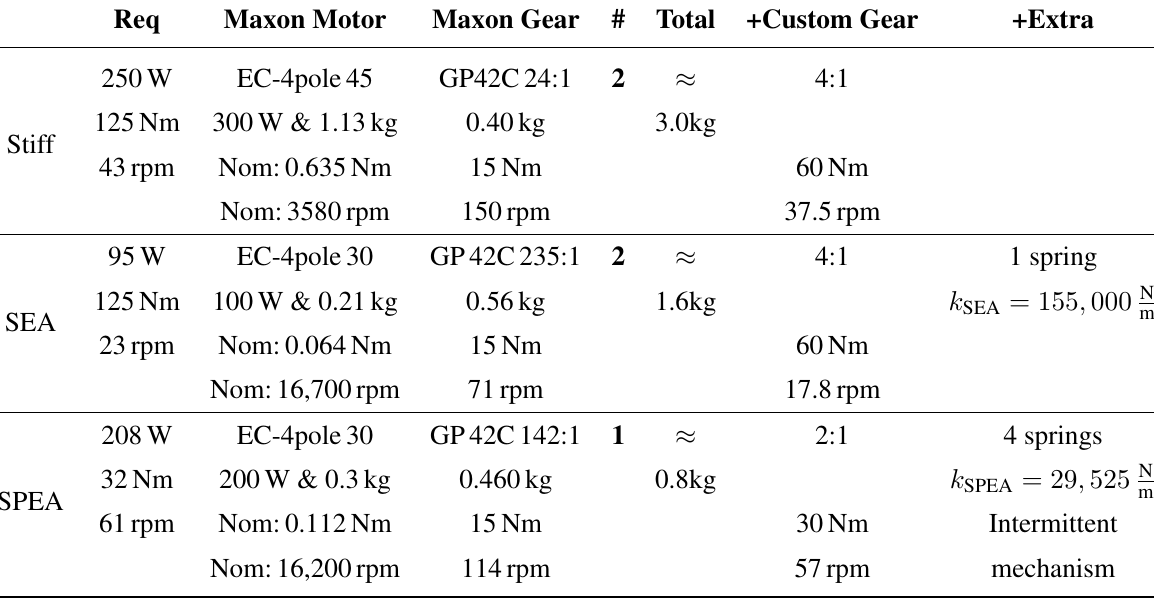
Table 1. Summary of the results for the stiff set-up, SEA and SPEA. It is clear that the stiff set-up and SEA will be heavier than the